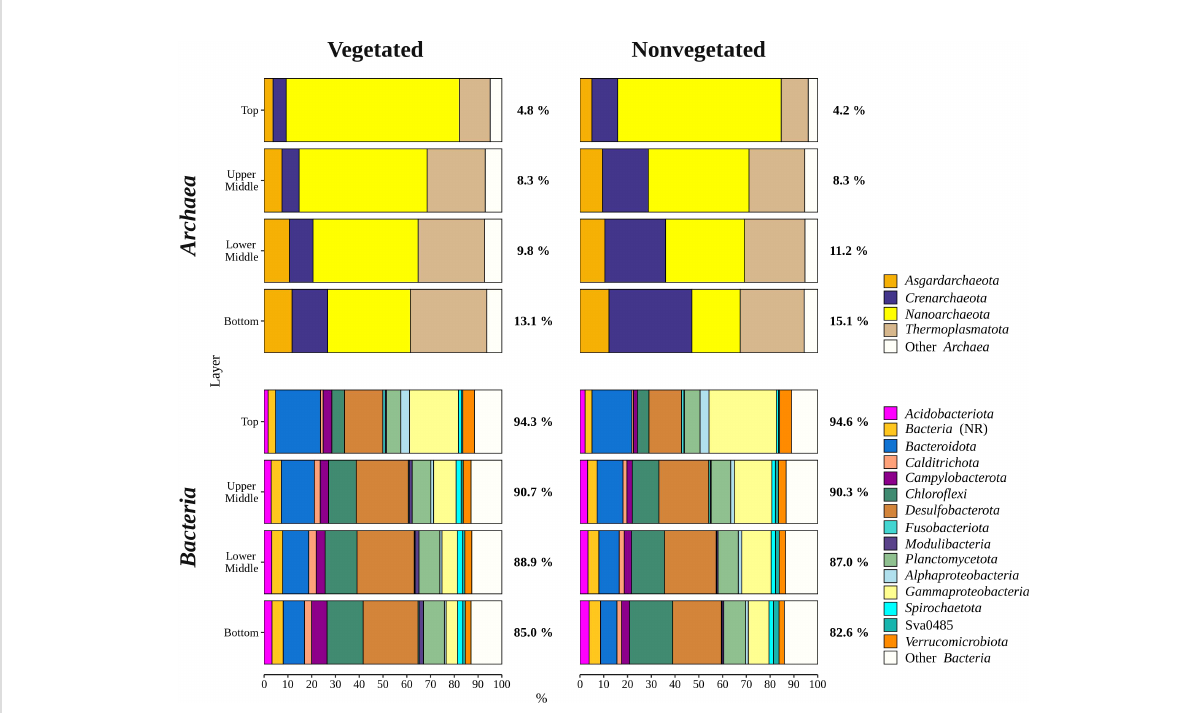
FIGURE 5 Taxonomic classi fi cation and relative contribution of the most abundant bacterial and archaeal ( ≥ 3%) sequences in sediment communities sampled at the vegetated and nonvegetated site in the Bay of Saline. NR – sequences without known relatives.